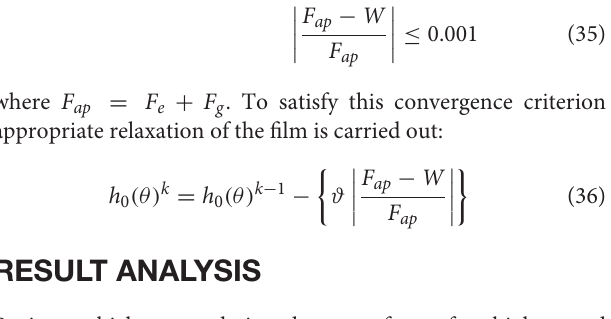
Frontiers in Mechanical Engineering |